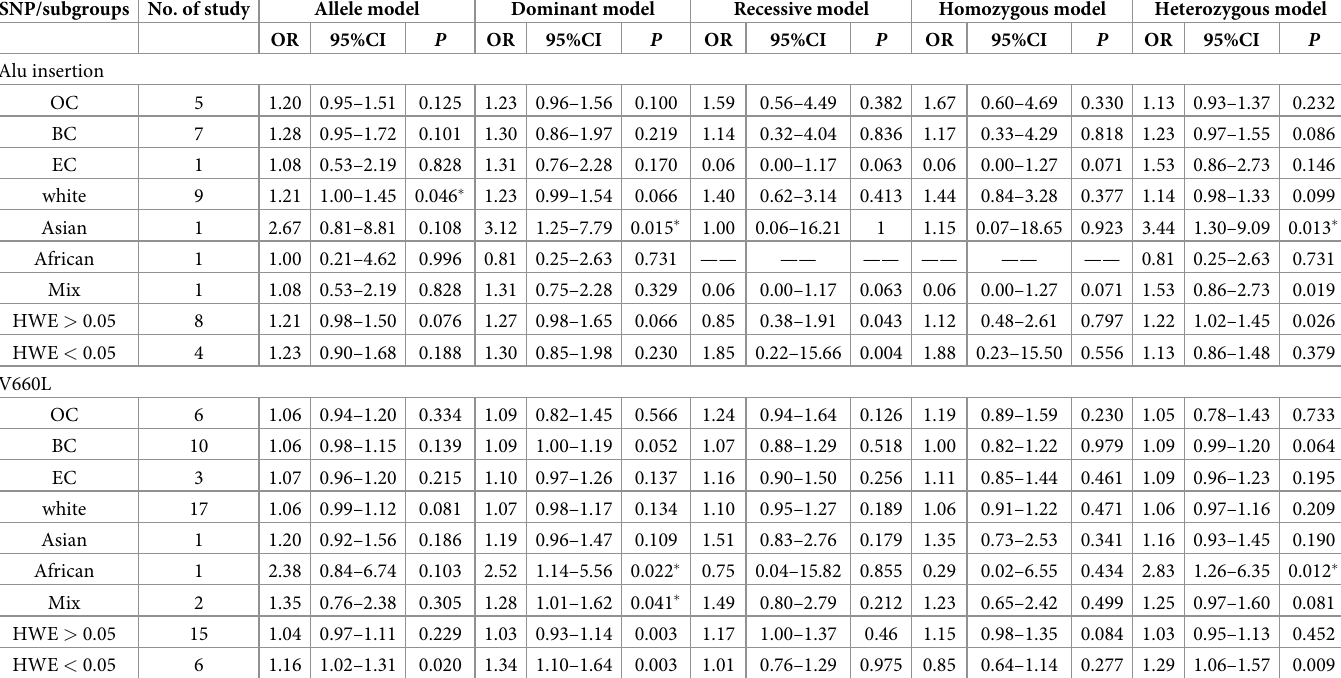
Table 4. Pooled odds ratios (ORs) in